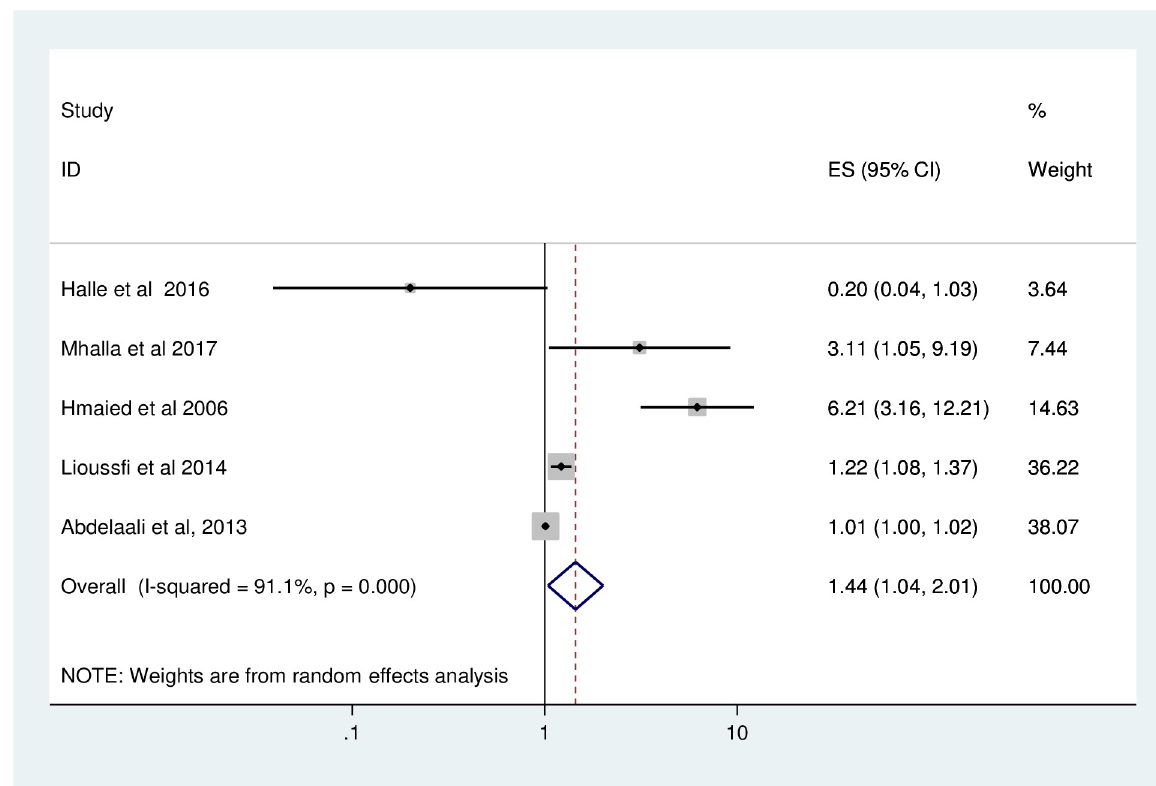
Fig 4. Forest plots which describe associated factor (duration of dialysis) of hepatitis among HD patients in Africa.